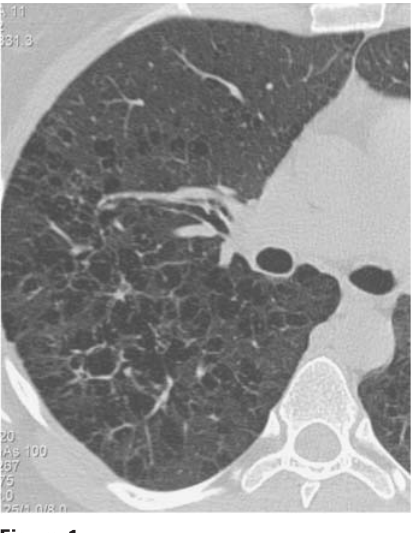
High-resolution computed tomographic scan of thorax showing multiple small nodules thin-walled and irregular